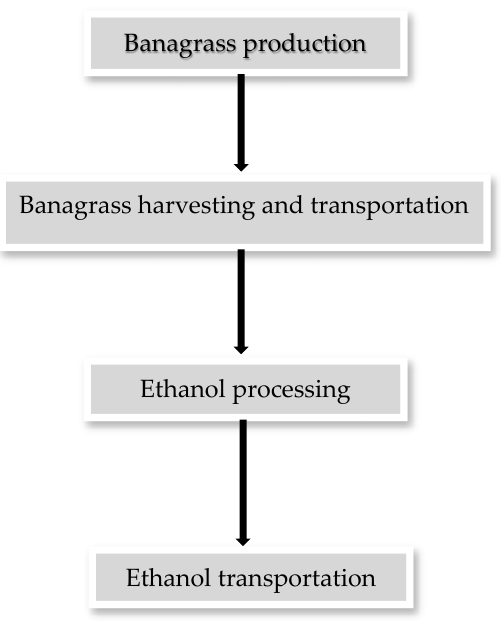
Figure 3. Framework for cost minimization analysis.